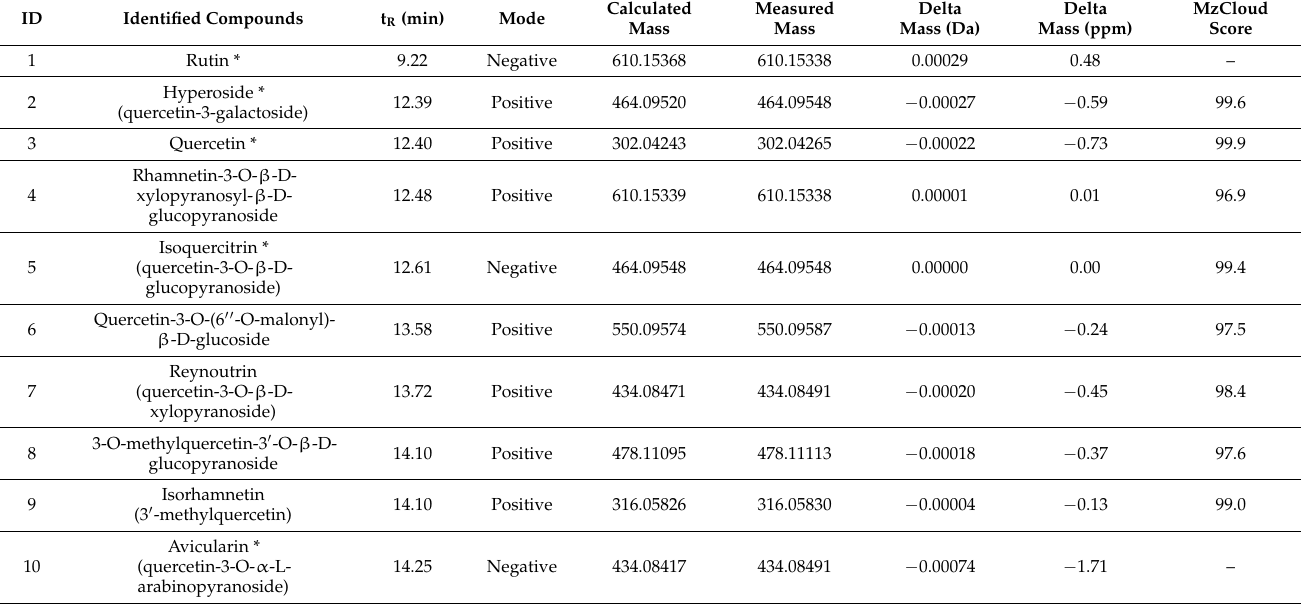
Table 1. Quercetin and its derivatives identified in water–ethanol extracts of S. hypericifolia